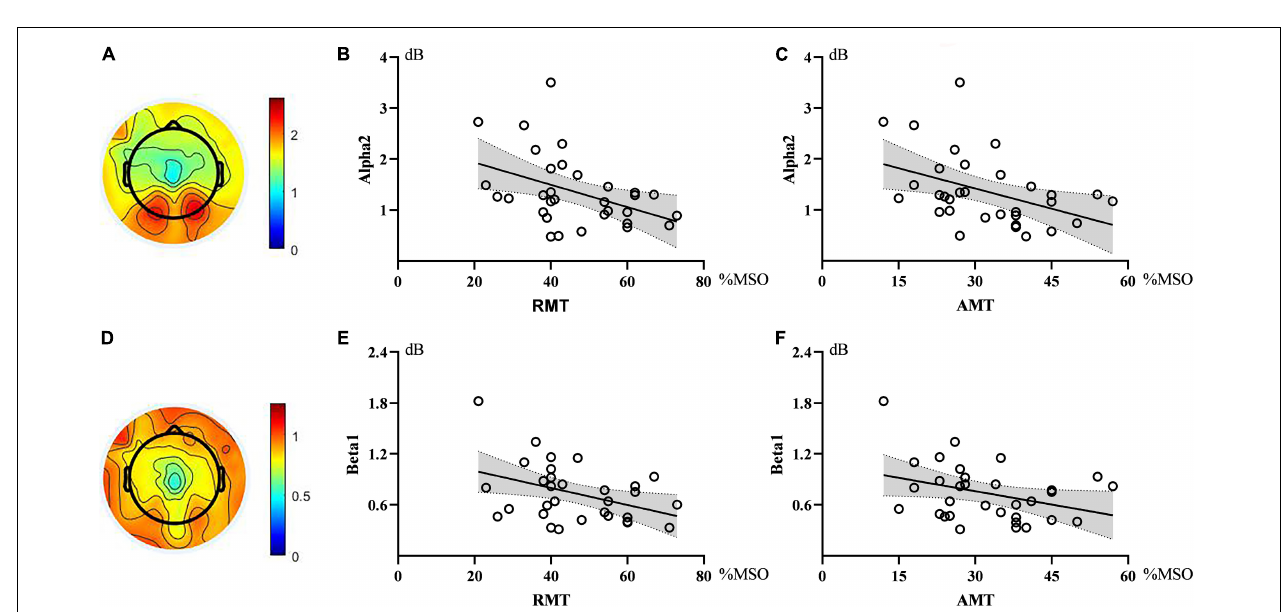
FIGURE 1 | Features selection using the least absolute shrinkage and selection operator (LASSO) regression model for resting motor threshold (RMT) (A) and active motor threshold (AMT) (B) . The horizontal axis plotted value of log λ and the vertical axis plotted mean squared error. The dotted vertical line was plotted at the optimal λ values based on minimum criteria.